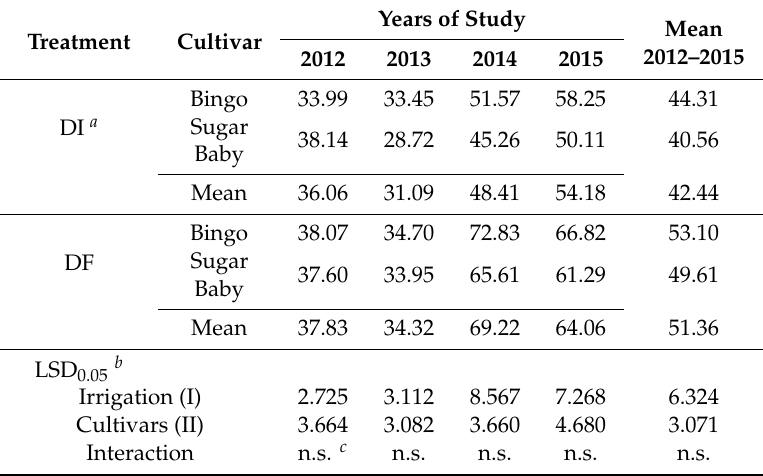
Table 4. Influence of nitrogen fertigation on the marketable yield of fruits (t ha − 1 ) of two watermelon cultivars: Bingo and Sugar Baby